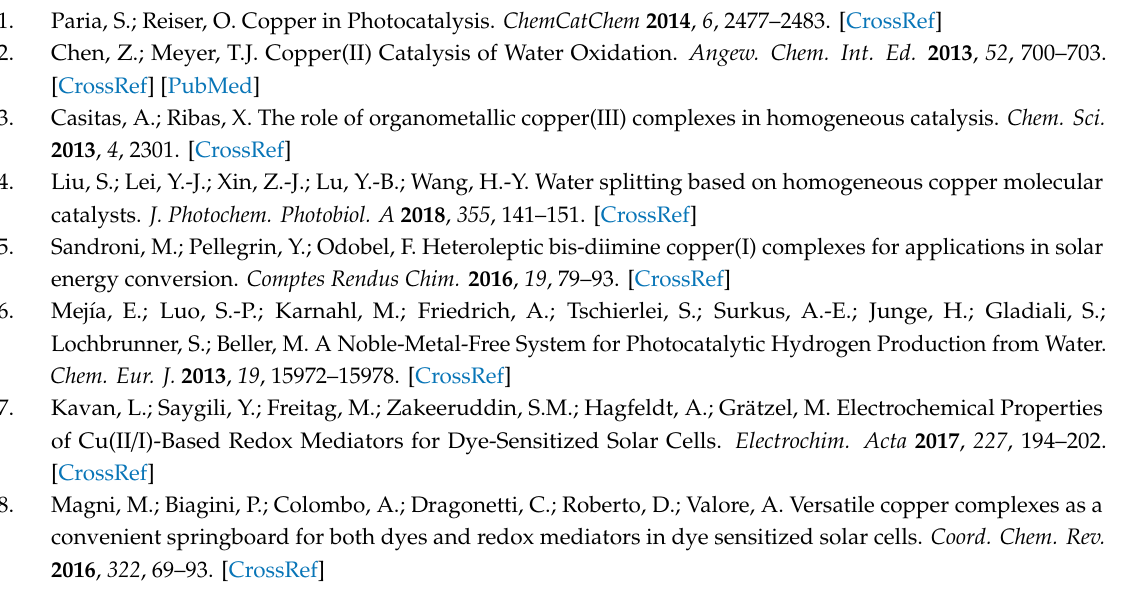
voltammograms (CVs) of the pq ligand (5.0 mM) in the absence (black curve) and the presence (coloured curves) of 1 mM (red), 2 mM (blue) and 4 mM (purple) of TFA recorded in a DMF solution of n-Bu 4 NPF 6 (0.1 M) on a glassy carbon electrode at a scan rate of 0.1 V s − 1 , Figure S4: Absorption spectra of [1] BF 4 in H 2 O:DMF 1:8 mixture with C = 2*10 − 4 M under visible light irradiation over a period of 24 h, Figure S5: Relative free energies of the 1H + protonated and 1e − reduced species [2] + tautomers, Figure S6: Relative free energies of the 2H + protonated and 2e − reduced species [3] + tautomers, Figure S7: Possible decomposition pathways of the intermediate [5] + in water, Figure S8: Relative free energies of the 3H + protonated and 3e − reduced species [4] + tautomers, Figure S9: Relative free energies of the 4H + protonated and 4e − reduced species [5] + tautomers, Figure S10: Higher occupied molecular orbital diagrams of the catalytic intermediates and spin densities on Cu ( ρ Cu) of intermediates with unpaired electrons, Table S1: Crystallographic data for complex [1] BF 4 , Table S2: Selected bond distances (Å) and angles ( o ) for [1] BF 4 , Table S3: Crystal data and structure refinement for C26 H18 B Cu F4 N6 at 100 K, Table S4: Atomic coordinates ( × 10 4 ) and equivalent isotropic displacement parameters (Å 2 × 10 3 ) for C26 H18 B Cu F4 N6 at 100 K with estimated standard deviations in parentheses, Table S5: Anisotropic displacement parameters (Å 2 × 10 3 ) for C26 H18 B Cu F4 N6 at 100 K with estimated standard deviations in parentheses, Table S6: Bond lengths [Å] for C26 H18 B Cu F4 N6 at 100 K with estimated standard deviations in parentheses, Table S7: Bond angles [ ◦ ] for C26 H18 B Cu F4 N6 at 100 K with estimated standard deviations in parentheses, Table S8: Electronic transitions of [Cu(pq) 2 ] + calculated with the TDDFT method, Table S9: Performance of the photocatalytic systems with [1] + as catalyst, di ff erent CdTe QDs as the photosensitizer and di ff erent e − donors in DMF:H 2 O 1:2 solvent mixture, Table S10: Comparison of the experimental (crystal structure) and DFT calculated (B3LYP / 6-31G**, gas phase) values of selected structural parameters of [Cu(pq) 2 ]BF 4 ( [1] BF 4 ), Table S11: The free energy of H 2 self-elimination from AH 2 was calculated from the following